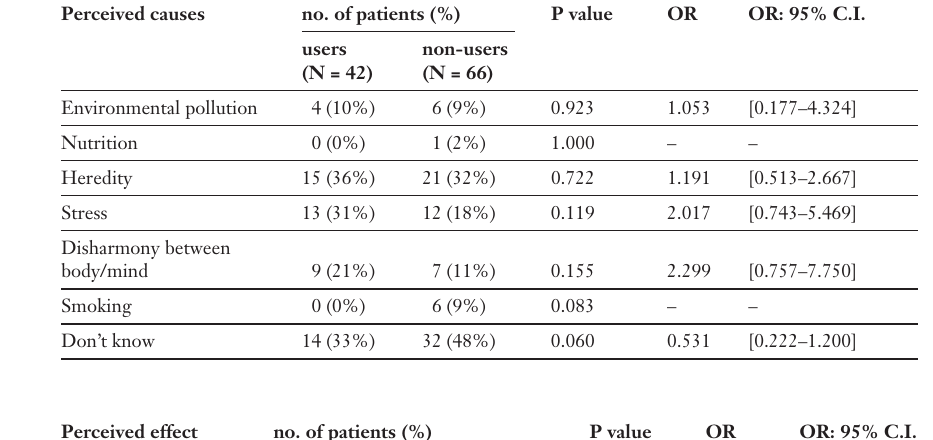
Perception of the effect of conventional cancer